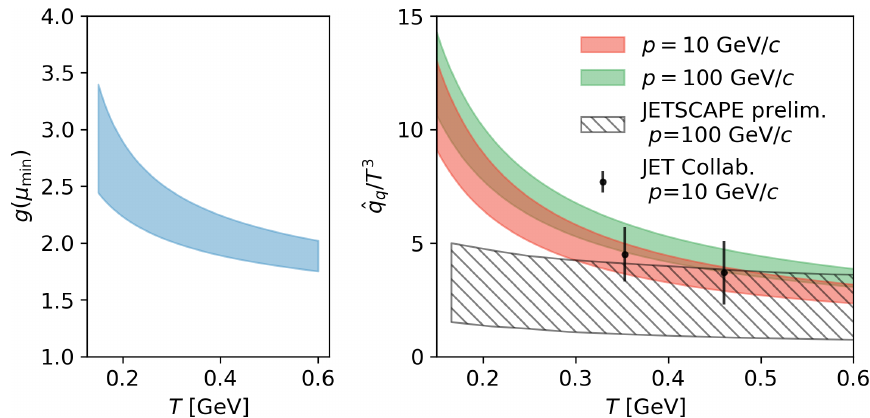
Figure 17 . The resultant 95% credible region of medium coupling strength g ( µ min ) as a function of temperature T (left) and jet transport coefficient for light quark ˆ q green bands correspond to the value of ˆ q/T 3 for a light quark with 10 GeV/ c and 100 GeV/ c momen- tum respectively. Black symbols with error bars are values estimated by the JET Collaboration [6] and the hatched band is one of the preliminary results extracted by the JETSCAPE Collabora- tion